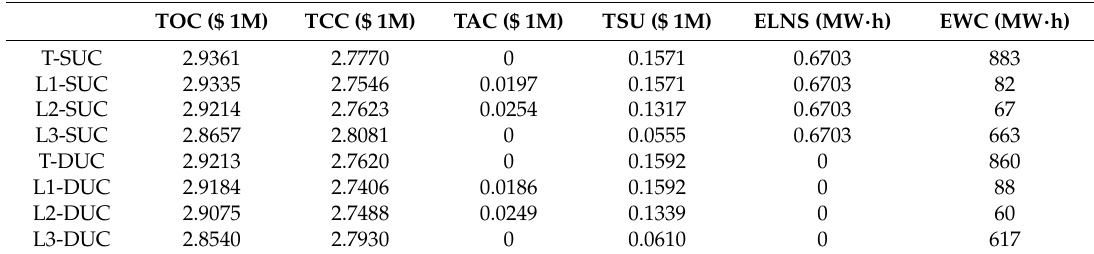
Table 4. The results of different